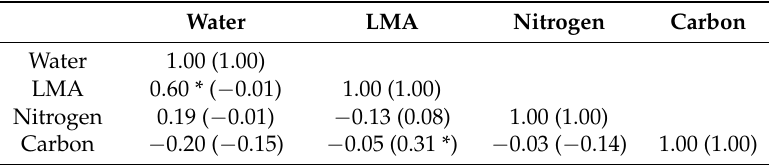
Table 2. Correlation coefficients between pairs of canopy biochemical